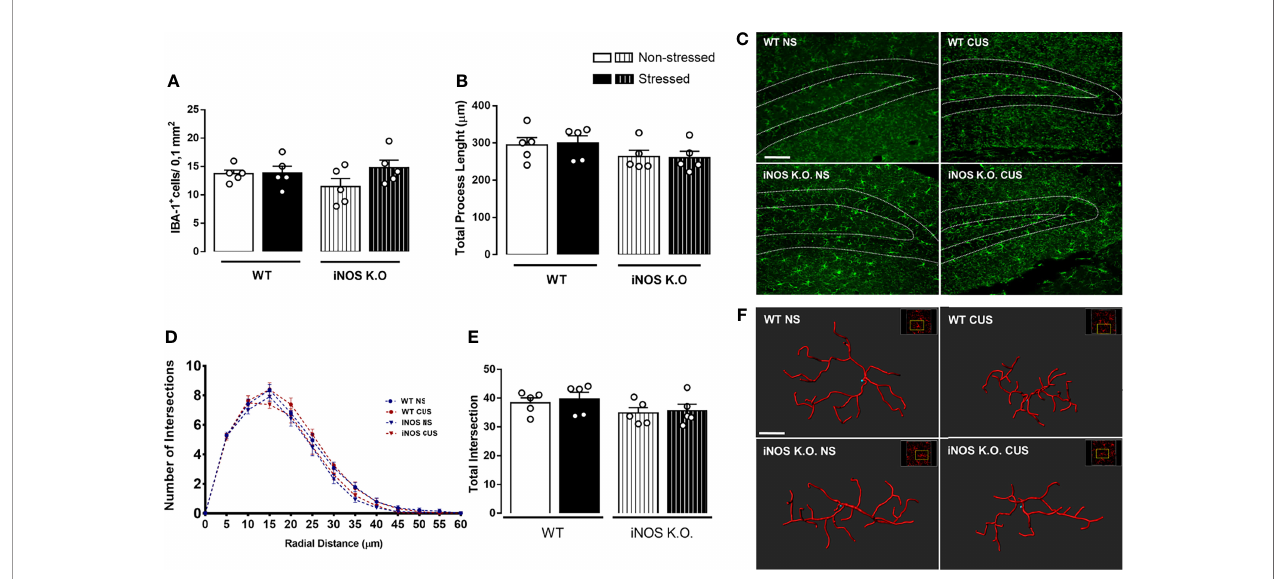
FIGURE 3 | Chronic unpredictable stress does not alter microglia density (A) or complexity (C – E) on the granular zone of the dentate gyrus neither of WT or iNOS KO mice (B) . Representative photomicrography of dentate gyrus of all groups analyzed (scale bar = 99,98 µm) and fi lament 3D reconstruction on IMARIS (scale bar = 7 µm) (F) . Data presented as mean ± SEM